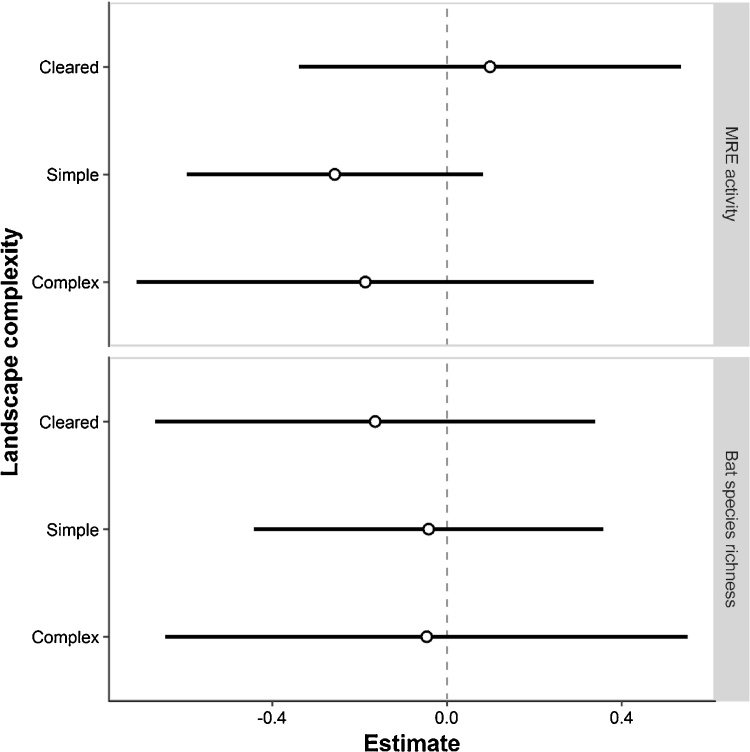
Effects of farming system (organic vs. conventional) on the activity of mid-range echolocator bats (MRE guild) and bat species richness in a gradient of landscape complexity at 3.0 km radius scale. Estimates and associated 95% confidence intervals arising from the pairwise comparisons of least-square means (“lsmeans” package) used to investigate variable interactions in GLMMs (see Section 2.5. Statistical analysis) are shown with white circles and black solid lines, respectively. Values on the right side of the dotted line suggest higher bat activity or species richness in organic vineyards. None of the comparisons are statistically significant (P-values >0.05). Cleared landscapes (6 pairs): extremely simplified landscape with <1% of forest and semi-natural areas; Simple landscapes (10 pairs): 1–20% of forest and semi-natural areas; Complex landscapes (5 pairs): >20% of forest and semi-natural areas (Tscharntke et al., 2012).